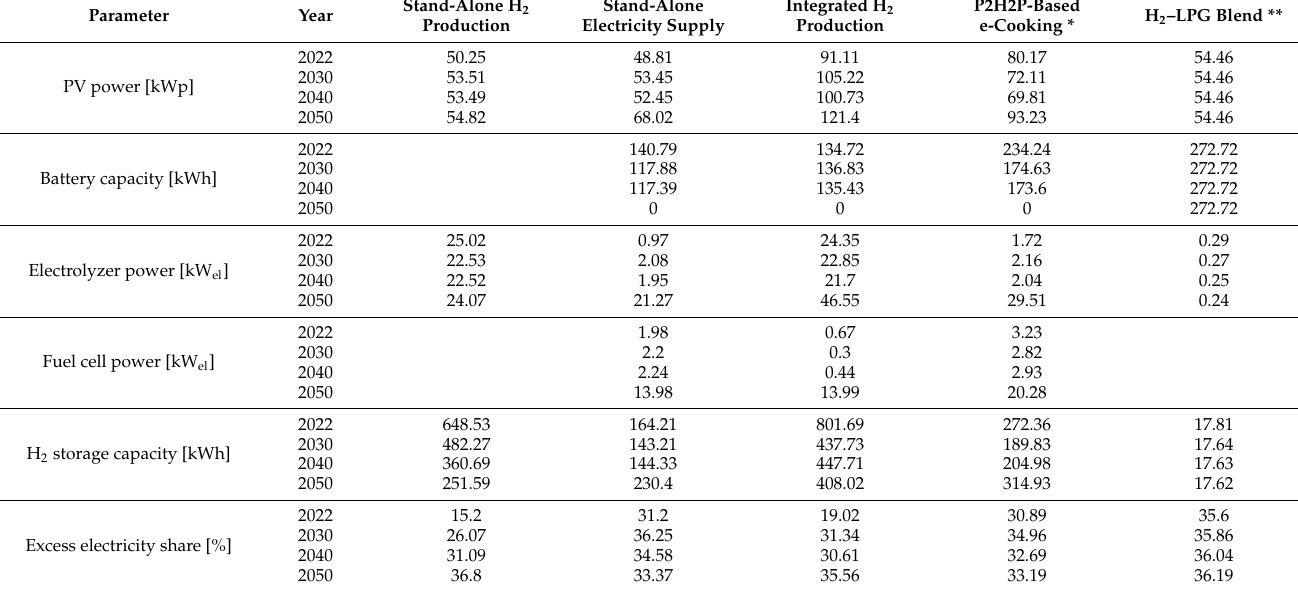
Table 6. Least costly (optimal) system topologies of the hydrogen-based energy systems. * The demand of electricity required for e-cooking decreases with the substitution of AC EPCs and electric hotplates in 2030 by approximately 40%, as explained in Cooking Demand. ** Note that we assume a standard PV–battery electricity supply system with fixed component sizes and only use excess electricity for hydrogen production, as explained in Section 2.1 and Cooking